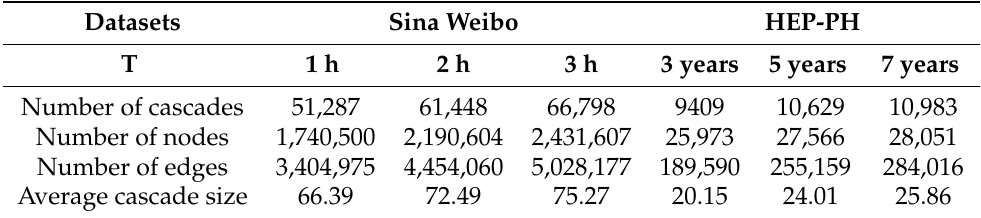
Table 1. Descriptive statistics of two datasets. T refers to the observation time